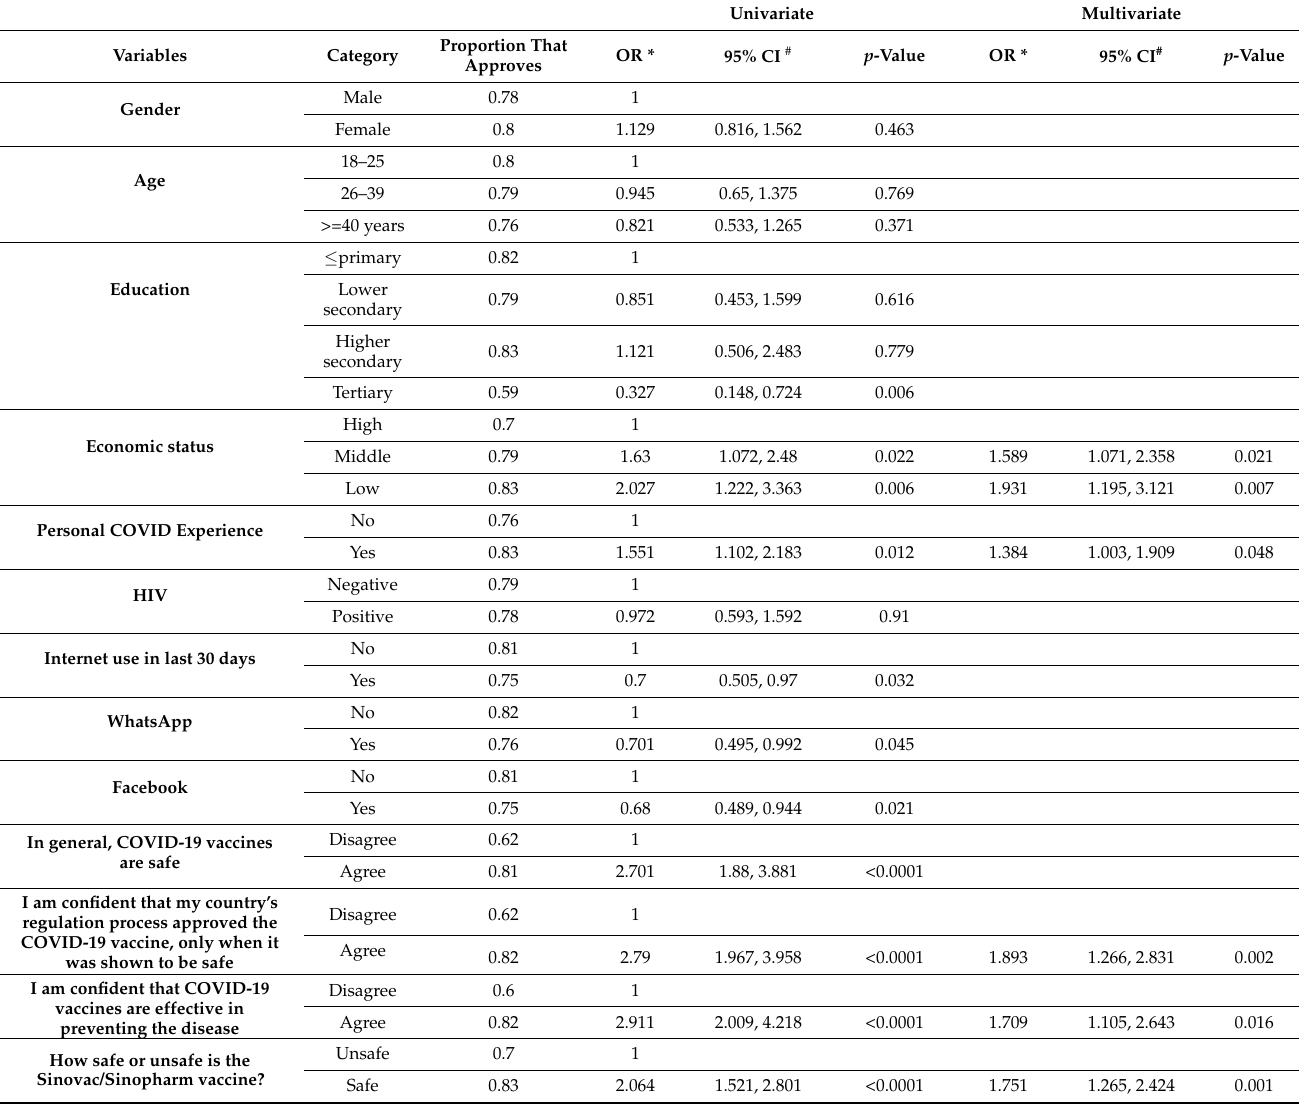
Table 5. Do you think schools should require students to be vaccinated for COVID-19 as they do for most other diseases such as measles and tuberculosis? (Yes; analysis of only those who indicated that they have children below age 18 years in the